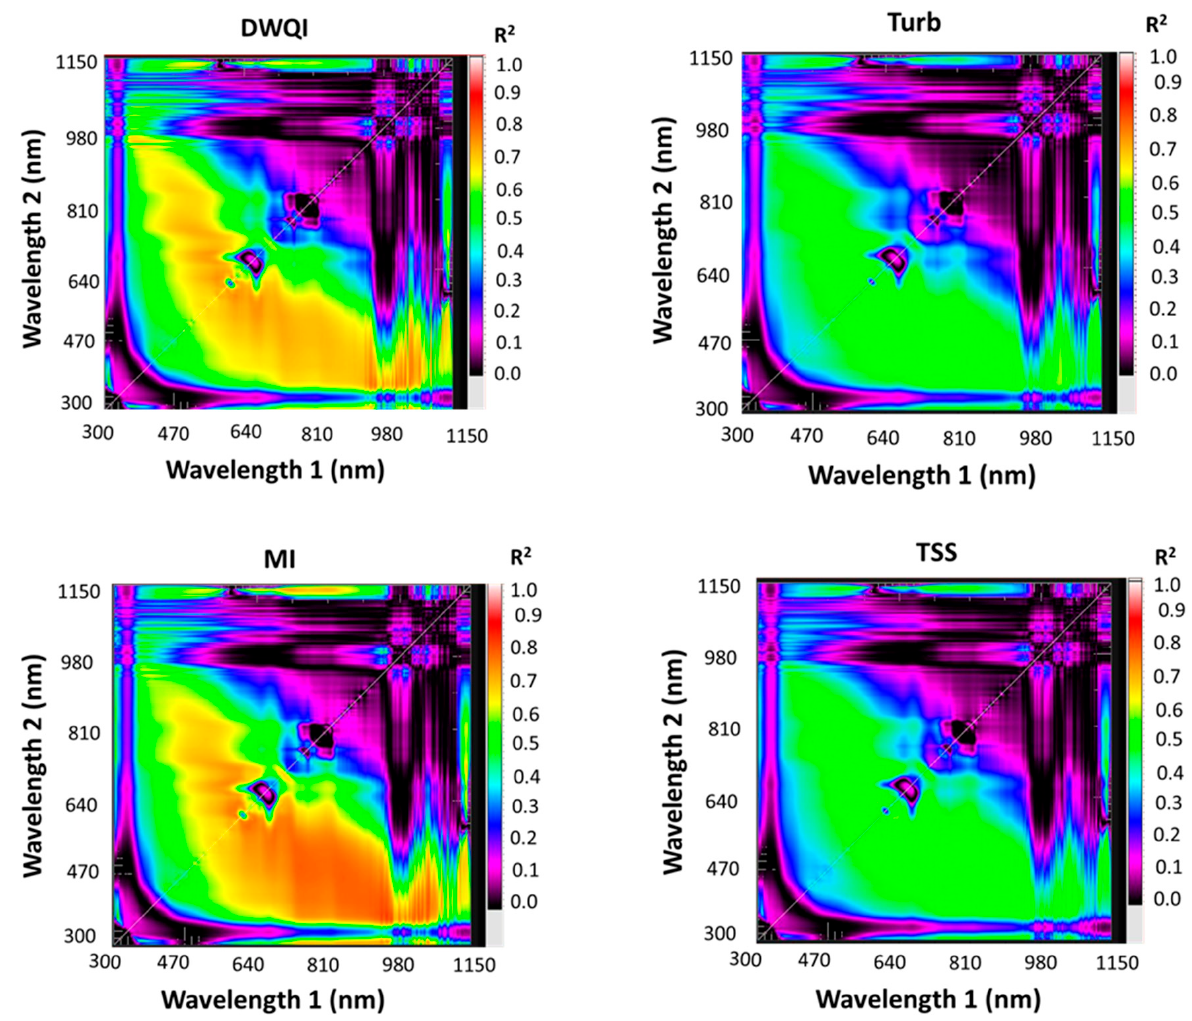
Figure 9. Correlation matrices show R 2 values for the spectra’s potential dull wavelength combina- tions in the spectrum from 302 to 1148 nm with drinking water quality index (DWQI), metal index (MI), turbidity (Turb.) and total suspended solids (TSS). R 2 values were calculated across all pooled data (n = 51). Table 7. R 2 for the linear association between SRIs and drinking water quality index (DWQI), metal index (MI), turbidity (Turb.) and total suspended solids (TSS). Estimates were calculated for Rosetta branch (n = 21), Damietta branch (n = 30) and across all data (n = 51). Rosetta and Damietta Rosetta Branch Damietta Branch